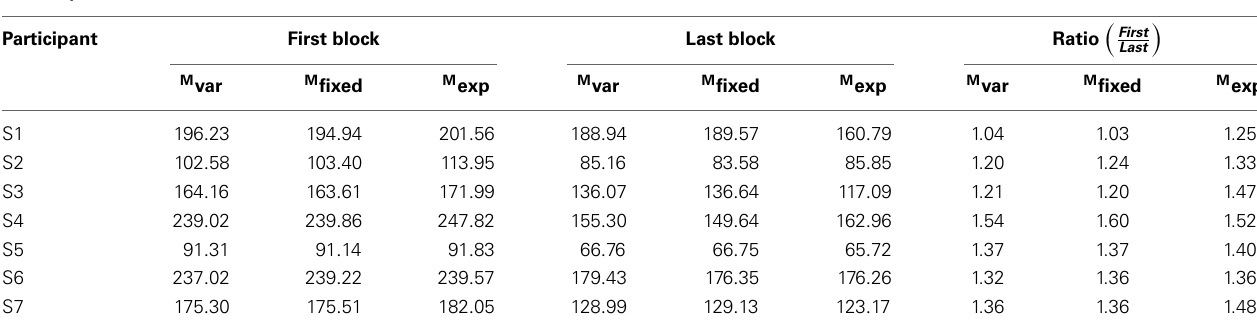
Table 2 | Estimated first and last PF 50% points.